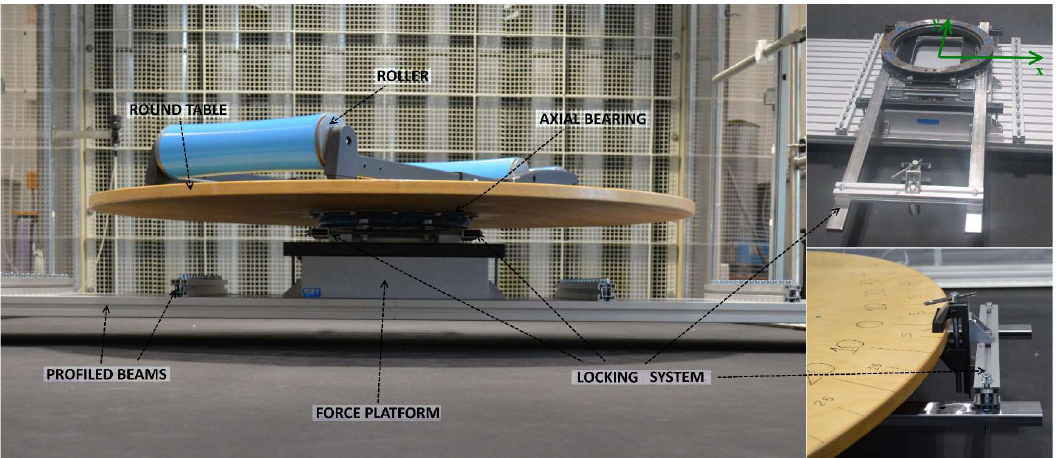
Figure 1. Front view of the supporting system with all the parts and details of the locking